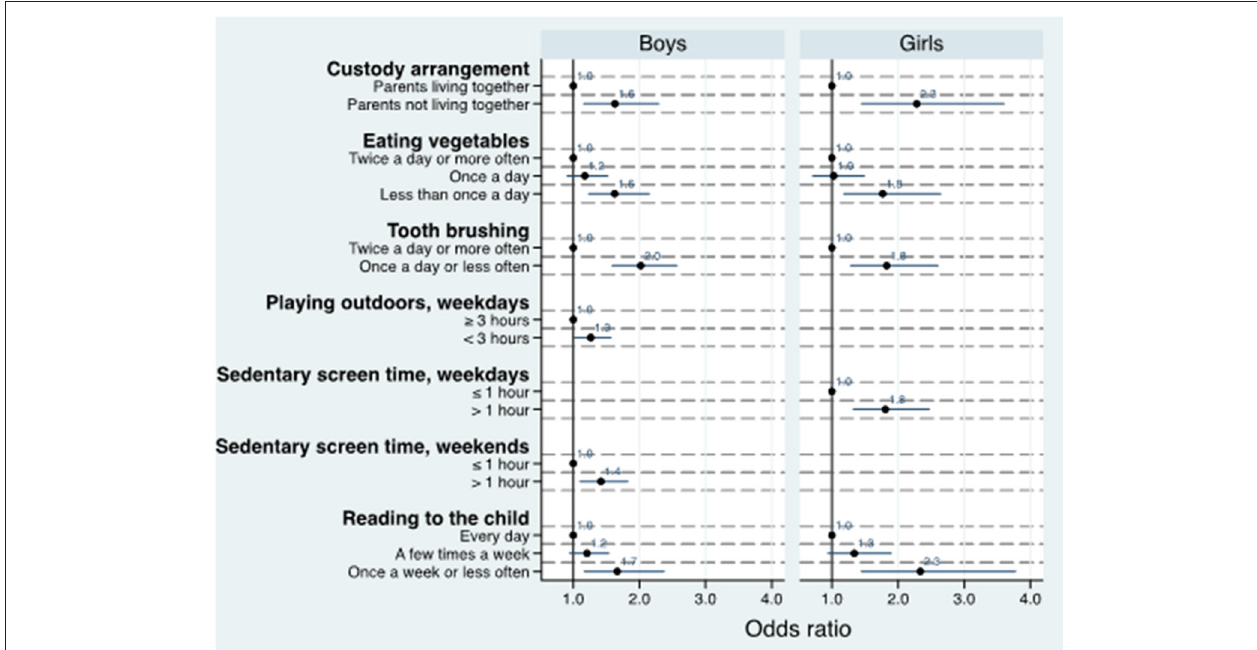
FIGURE 1 | Adjusted estimates a of the association between 3-year-olds’ lifestyle and social-emotional problems as measured by ASQ:SE b . a Multiple logistic regression with backward elimination included only variables that were still significant in the final analyses. b The first edition of the Ages and Stages Questionnaires: Social-Emotional (ASQ:SE) for 36-month